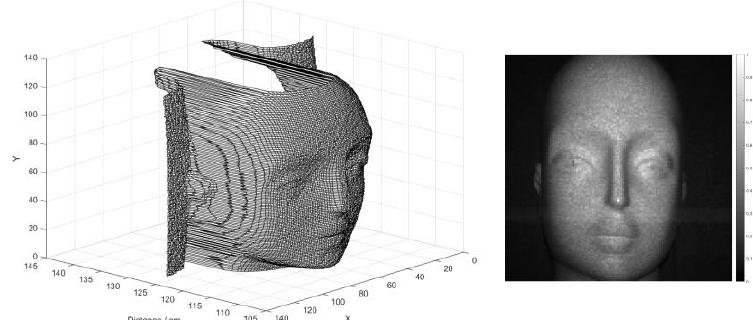
Figure 19. Scan imaging of a mannequin at distance of 1.3 m with a resolution of 128 × 128, where both the depth and intensity images were obtained at the same time.